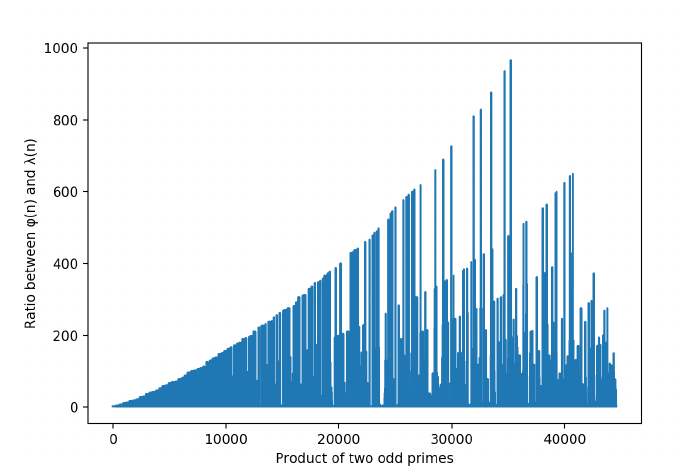
Figure 3. The Ratio between Carmichael and Euler functions for n less than 45,000.